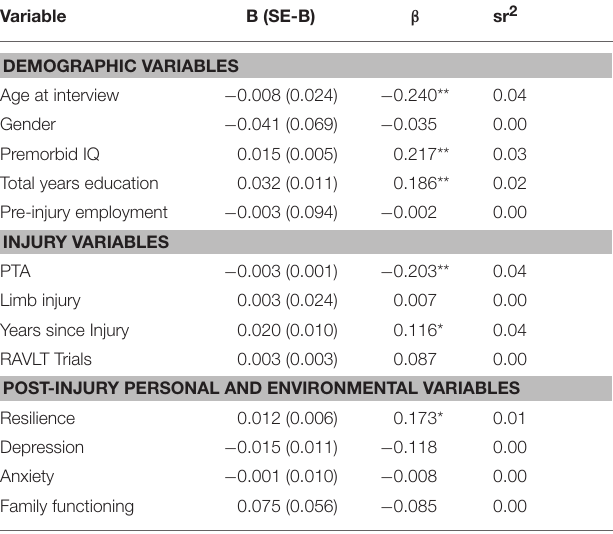
TABLE 2 | Unstandardized and standardized regression coefficients predicting participation outcomes and squared semi-partial correlations ( N = 225). Variable